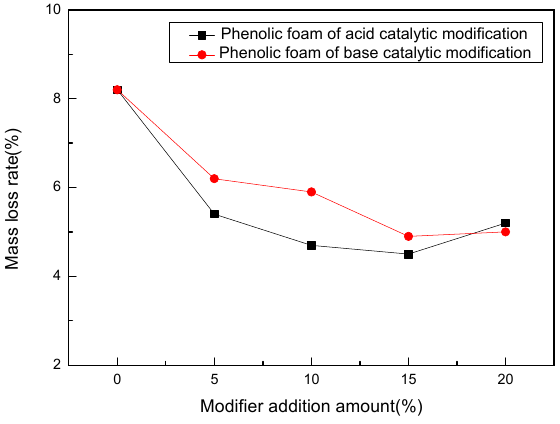
Figure 6. Mass loss rate variation curve of phenolic foam and modified phenolic foam.